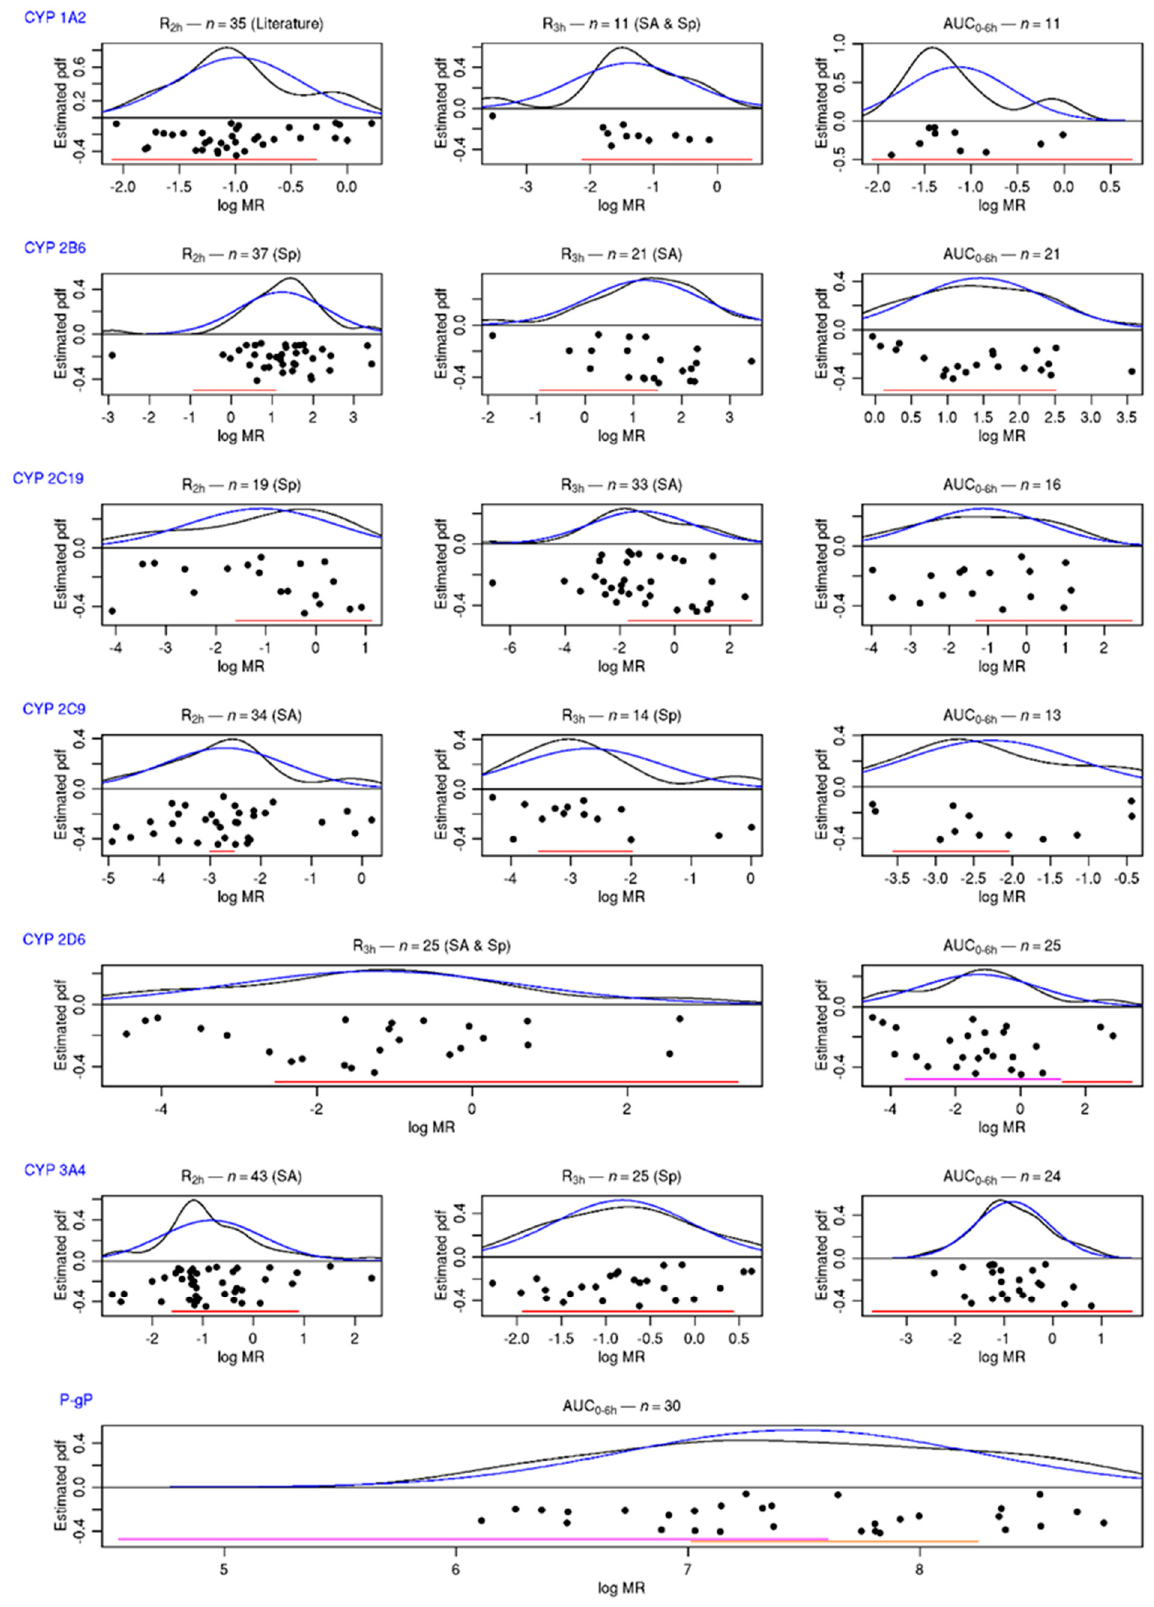
Probabilities are given with their 95% con fi dence interval. SA: best time to predict AUC MR, accord- ing to sensitivity analysis. Sp: highest Spearman correlation coe ffi cient with AUC MR. Literature: time to predict AUC MR in literature.